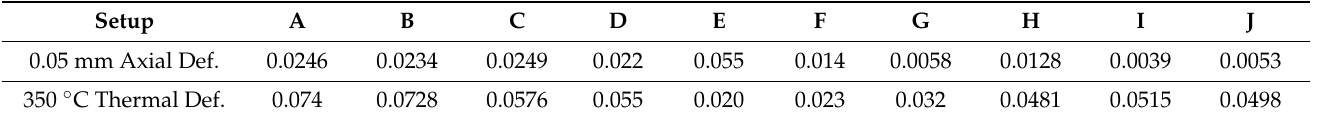
Table 8. Deformation effects on ELC sensor.